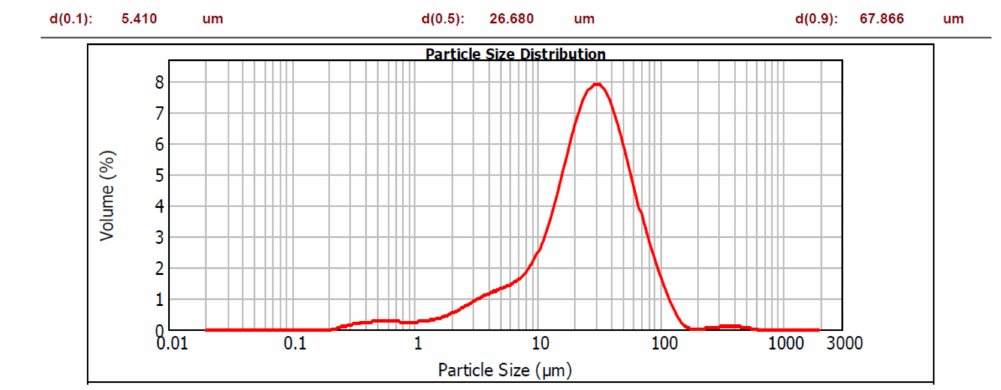
Figure 1. Particle size distribution of cement.